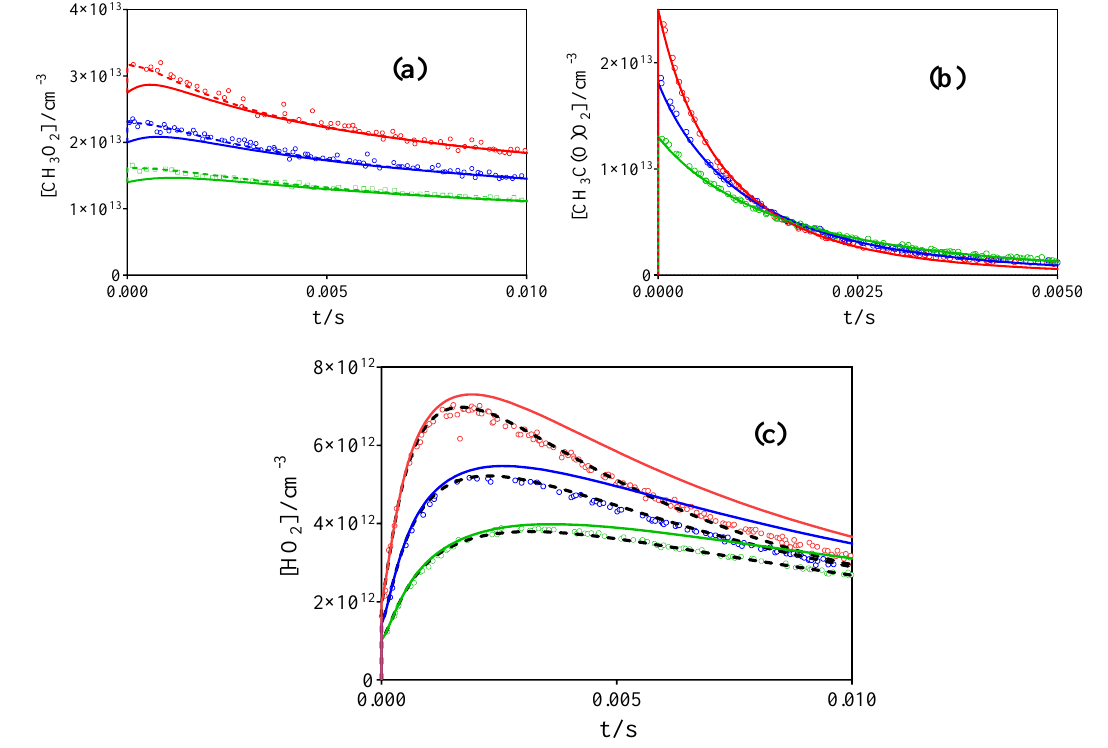
Figure 7. Concentration-time profiles of CH 3 O 2 • ( a ), CH 3 C(O)O 2 • ( b ) and HO 2 • ( c ) following the 248 nm photolysis of 3 different concentration of CH 3 C(O)C(O)CH 3 (8.67 (red), 5.79 (blue) and 2.85 × 10 16 cm − 3 (green)) at a total pressure of 200 Torr O 2 . Full lines simulation with rate constants from Table 3, dashed black lines using a rate constant for HO 2 • self-reaction of 5 × 10 − 12 cm 3 s − 1 . Changes in CH 3 O 2 • and CH 3 C(O)O 2 • profiles are not visible and have been omitted from the graph.